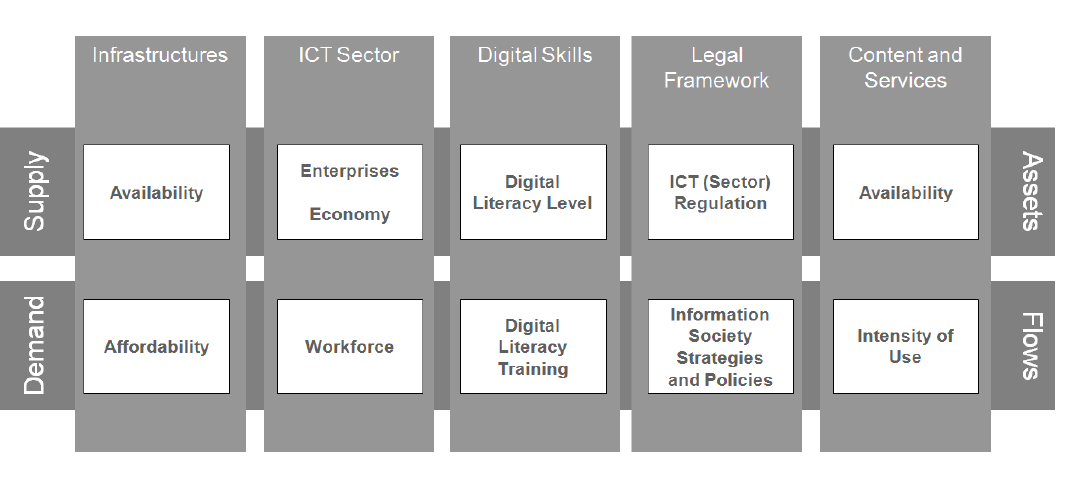
Figure 3: A comprehensive 360º digital framework to model the digital economy (Peña-López,